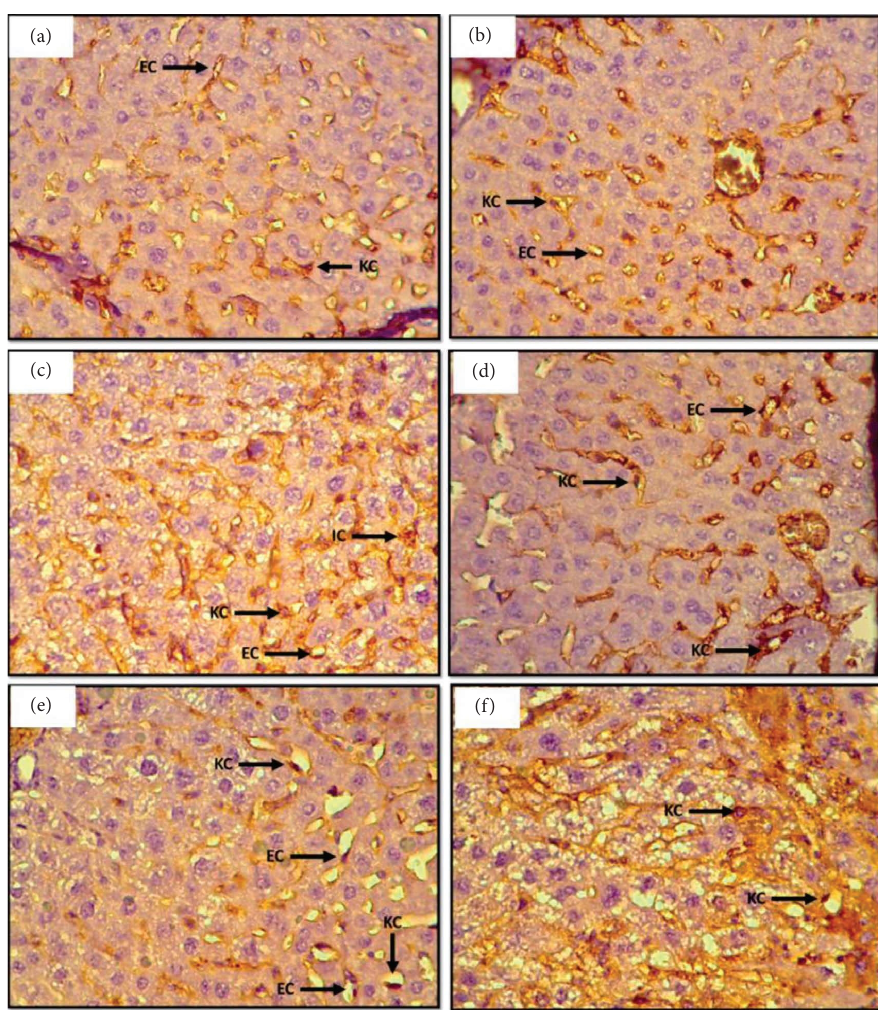
Figure 2: Liver section in mice showing immunohistochemical staining method detection of Ki-67 stained positive cells. (a) Control group showing a negative reaction in hepatocytes with weak positive stain in endothelial cells (EC) and Kupfer cells (KC). (b) Treated with ZnCl 2 10mg/k showing almost similar reaction to control. (c) Treated with CdCl 2 1.5mg/k the number of positive cells (brown stain) signifcantly increased. (d) Treated with ZnCl 2 10+CdCl 2 1.5mg/k. (e) Treated with CdCl 2 3mg/k, the arrows show increased immunoreaction. (F) Treated with ZnCl 2 10+CdCl 2 3mg/k,